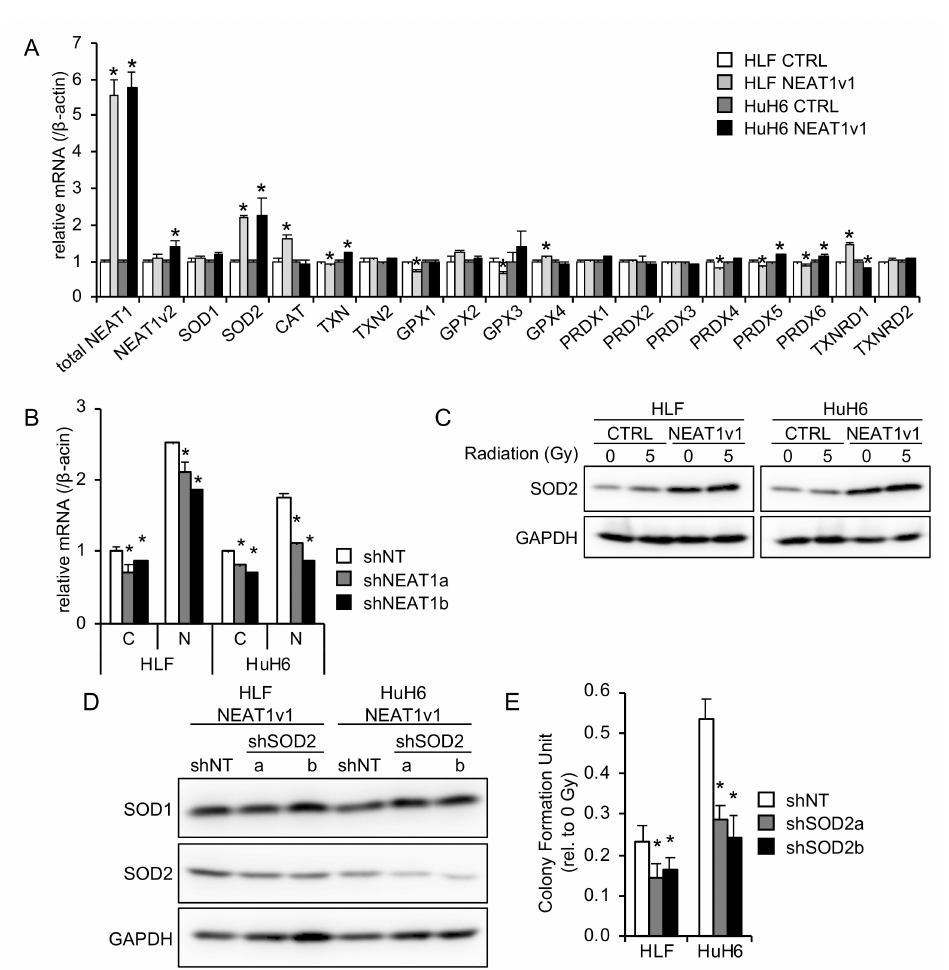
Figure 3. Involvement of SOD2 in NEAT1v1-induced radioresistance. ( A ) MRNA expression levels of genes encoding antioxidative enzymes in NEAT1v1-overexpressing cells. * p < 0.05 [Student’s t -test, control (CTRL) vs. NEAT1v1-overexpressing cells; n = 3]. ( B ) Expression levels of SOD2 mRNA in control (C) or NEAT1v1-overexpressing cells (N) transduced with adenoviruses express- ing nontarget shRNA (shNT) or NEAT1-specific shRNAs (shNEAT1a and shNEAT1b). * p < 0.05 (Dunnett’s test vs. shNT; n = 3). ( C ) Representative Western blot images for SOD2 and GAPDH (in- ternal control) using whole-cell lysates after 0 or 5 Gy irradiation. ( D ) Representative Western blot images for SOD1, SOD2, and GAPDH (internal control) using whole-cell lysates of cells transduced with adenoviruses expressing shNT or SOD2-specific shRNAs (shSOD2a and shSOD2b). ( E ) Colony formation abilities of NEAT1v1-overexpressing cells knocked down for SOD2 after 2.5 Gy irradiation. * p < 0.05 (Dunnett’s test vs. shNT; n =